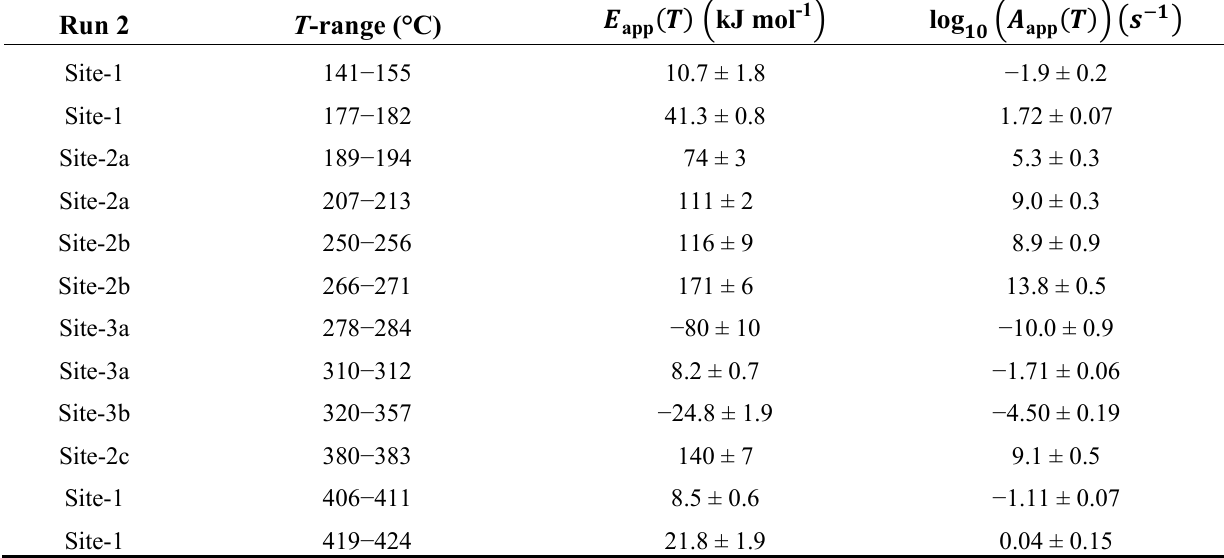
Table 2. Apparent activation energies and prefactors for each peak, plateau and shoulder plotted in Figure 2. Site-1 are assigned to isobutene desorption. Site-2a, Site-2b and Site-2c are isobutane dehydrogenation and Site-3a to Site-3b are isobutene dimerization parameters.